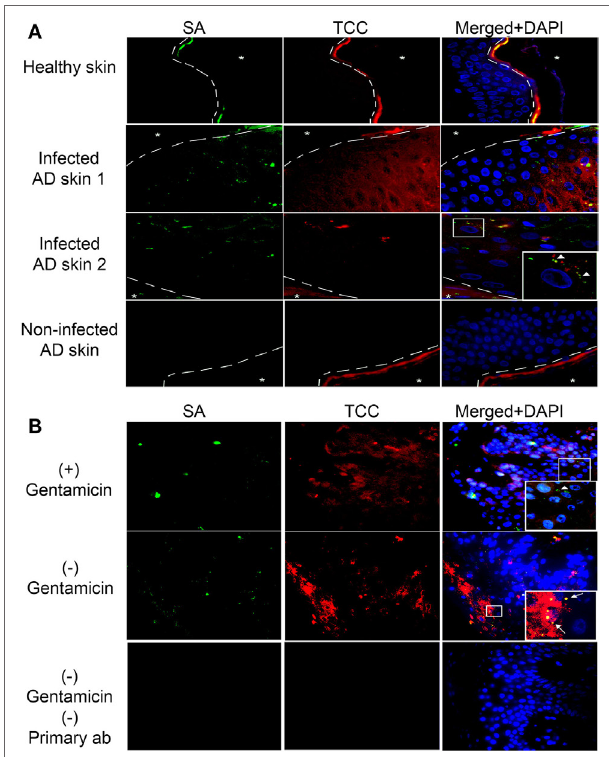
FigUre 4 | Complement activation in Staphylococcus aureus (SA) colonized atopic dermatitis (AD) epidermis. Representative immunofluorescence images of skin samples from healthy and AD patients stained for SA and terminal complement complex (TCC). (a) SA colonized AD epidermis shows an increase in TCC staining near infected keratinocytes, in comparison to healthy epidermis, or AD epidermis not colonized with SA. SA and TCC staining colocalized in some instances (arrow heads in inset), indicating deposition on extracellular bacteria, while in other instances it did not, suggesting intracellular localization of SA. (B) To confirm intracellular presence of SA, SA-infected AD epidermis was treated with gentamicin for 24 h to kill extracellular SA or left untreated, then incubated with normal human serum (NHS). Gentamicin treated epidermis showed SA staining, suggesting presence of intracellular SA (arrow heads in inset), while TCC staining did not colocalize with SA to the degree found in non-treated epidermis, which showed increased SA and TCC colocalization (arrows in inset). A no primary control is used for comparison of staining. Asterixis represent the apical side of the epidermis, which is not included in the investigation behind the dashed line due to the high unspecific binding of